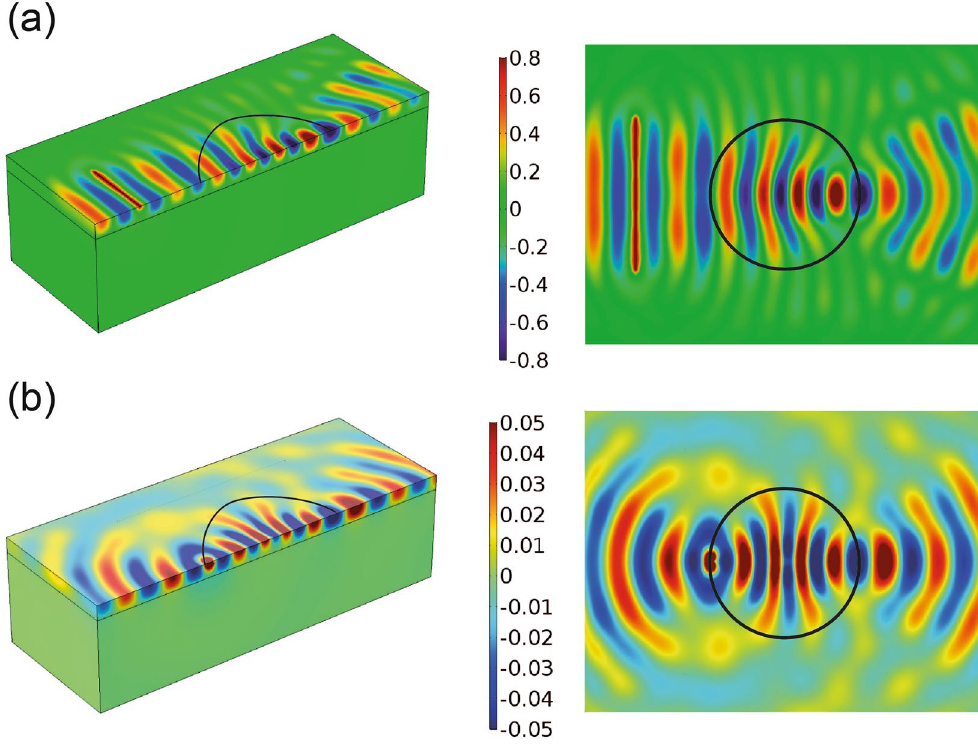
Figure 7. FE simulation of the design GRIN lenses. ( a ) Displacement field ( v component) of harmonic Love waves ( f * = 4.0 Hz) traveling through the Luneburg lens ( b ) Displacement field ( v component) of a harmonic point source ( f * = 4.0 Hz) focused by a Maxwell fish-eye